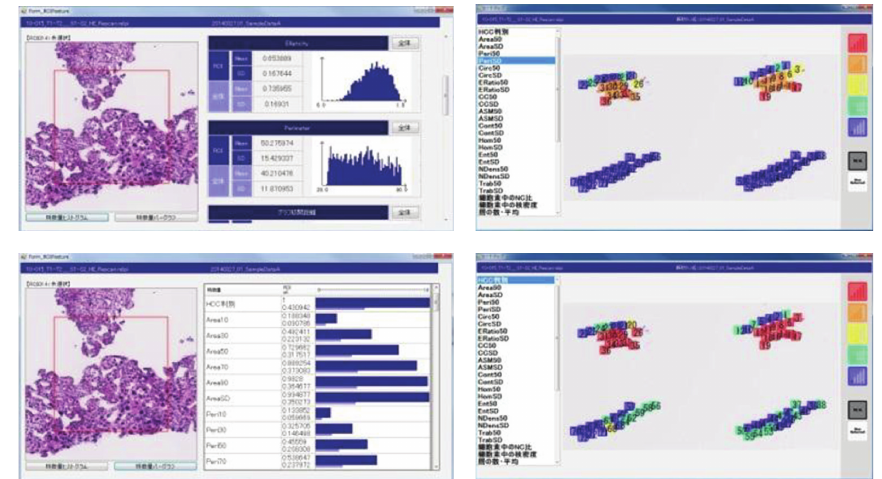
Figure 2: Visualization of morphological features.